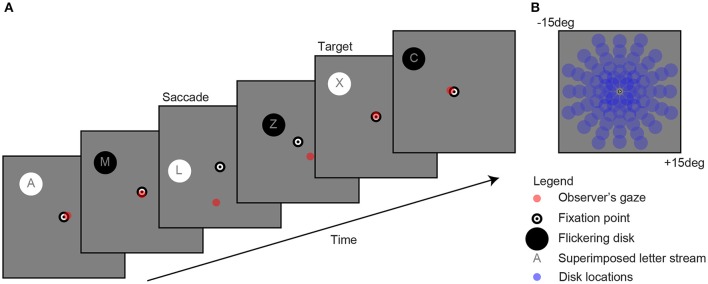
Example of a single trial (A). Observers fixated a bull's eye at the center of the screen while a flickering disk was presented in the periphery at one of 80 locations (B) to evoke pupil oscillations. A gaze-contingent stimulus presentation ensured that the retinal location of the stimulus was fixed (e.g., see saccade). The observer's task was to attend the stream of characters on top of the disk and mentally count the number of appearances of the letter “X.” For reasons of clarity, the scaling of the stimuli in the current figure diverges from those used in the actual experiment.